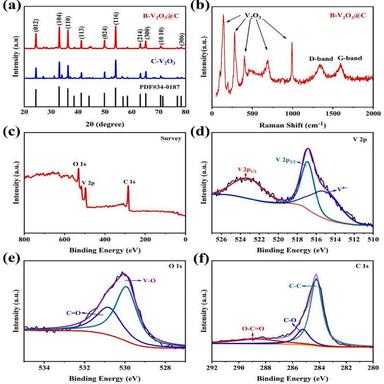
(a) XRD patterns of B–V2O3@C and C–V2O3. (b) Raman spectrum of B–V2O3@C. (c) XPS survey spectrum of B–V2O3@C. XPS fine spectrum of V 2p (d), O 1s (e) and C 1s (f) for B–V2O3@C.